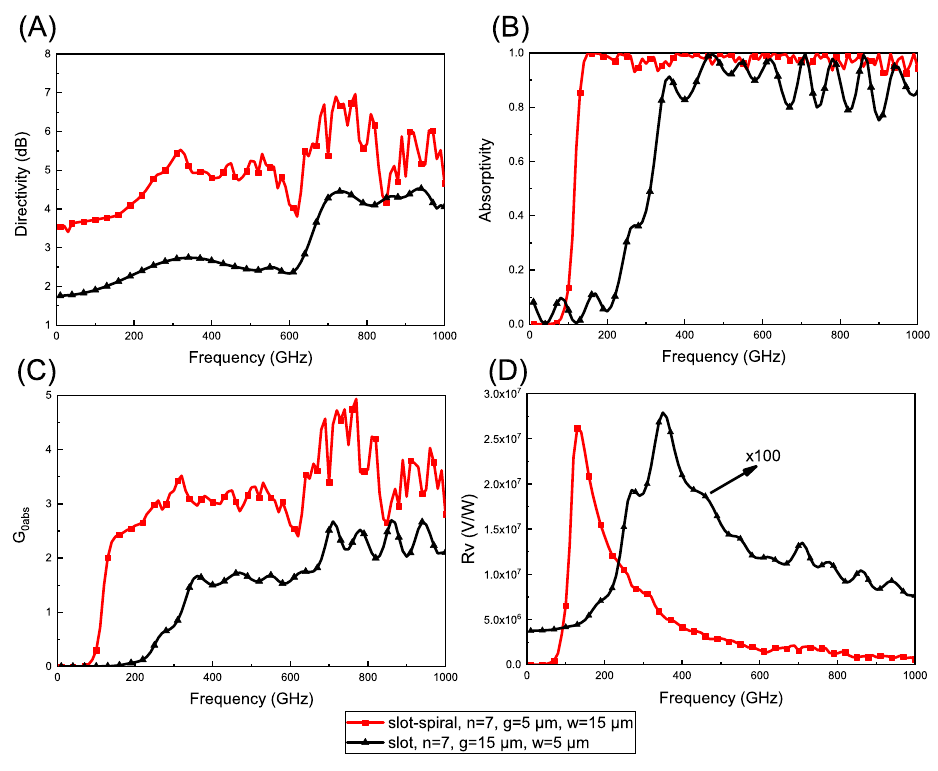
Figure 9. Comparisons of slot-spiral structure and spiral structure: ( A ) directivity versus frequency, ( B ) absorptivity versus frequency, ( C ) G 0 abs versus frequency, and ( D ) R V versus